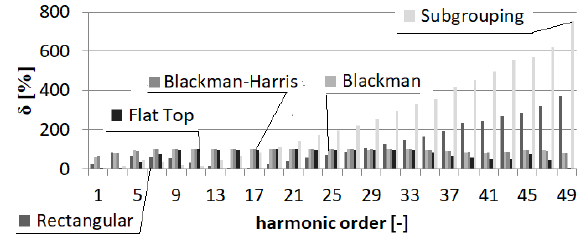
Fig. 6. Distribution of relative error of odd harmonics for the triangular test signal (50.1 Hz).